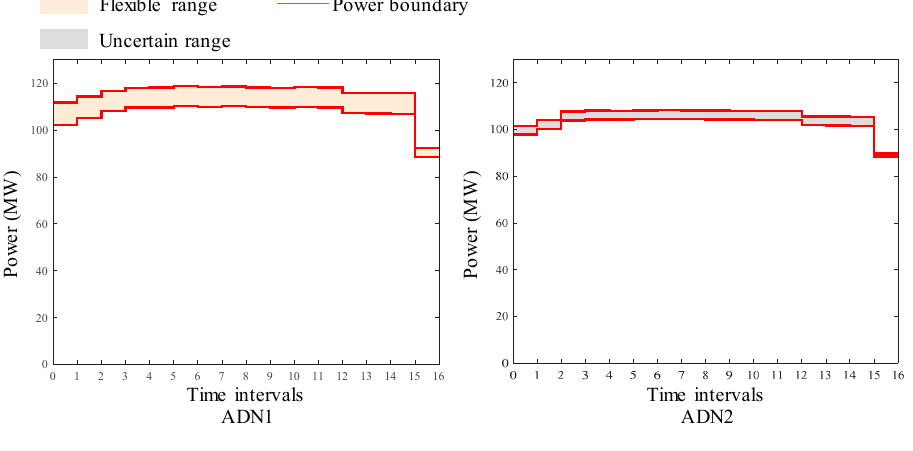
Figure 7. Optimization results of ADNs.